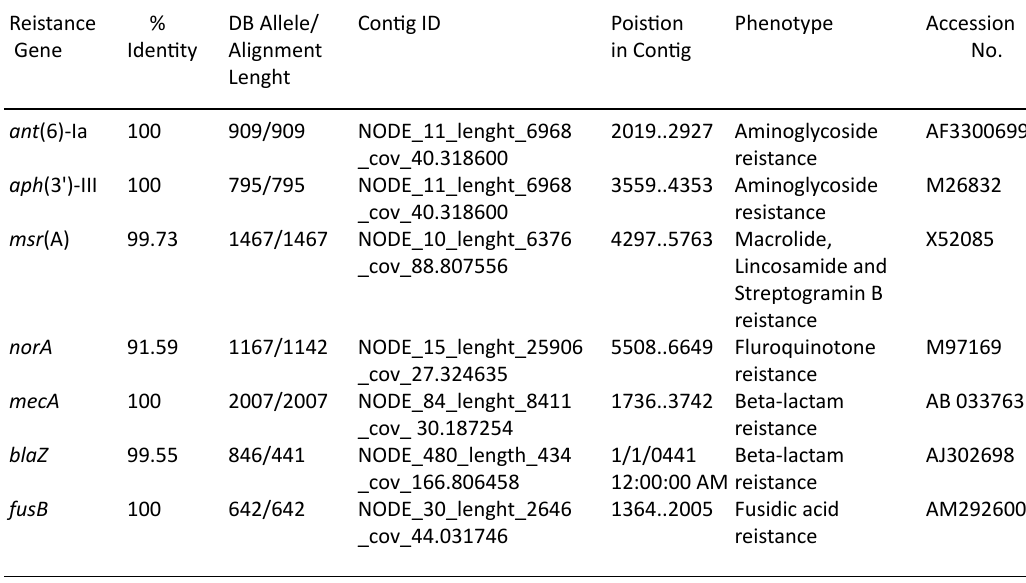
Table 3. Whole genome sequencing results showing different antibiotic resistance genes and virulence factors